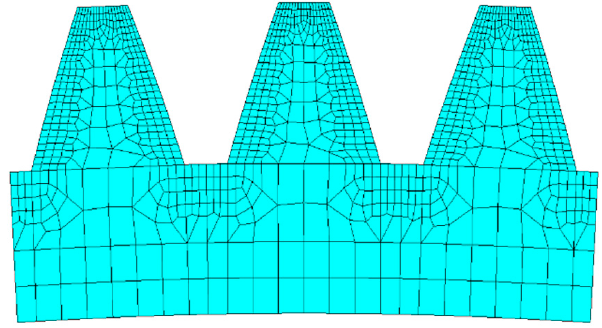
Figure 3. Mesh model of the flexible wheel profile.